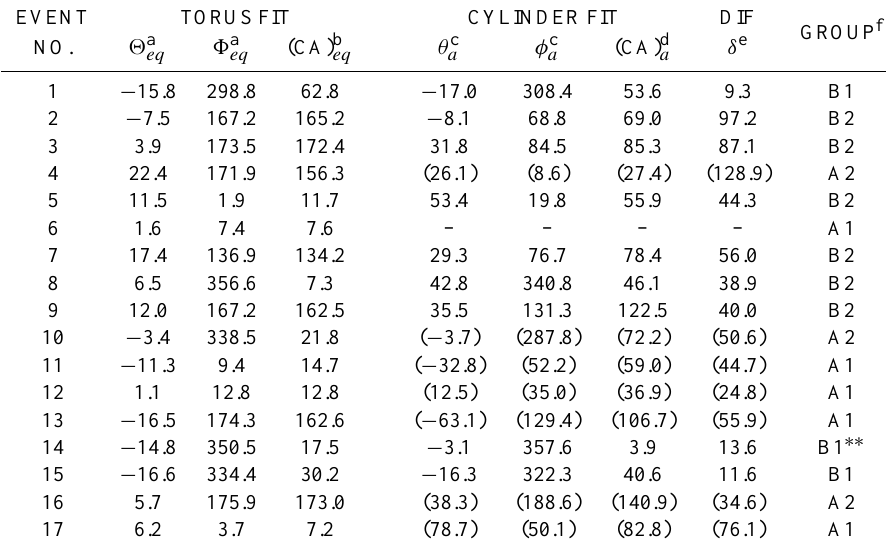
Table 4. Comparison between magnetic cloud orientations obtained from the torus model and the cylinder model. EVENT TORUS